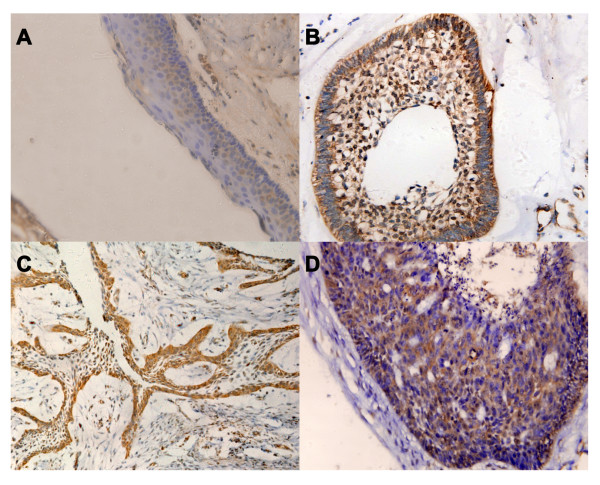
A representative immunohistochemical reactivity for MMP-2. (A) Keratocystic odontogenic tumor showing moderate reactivity in prickle cells (× 400); (B) Follicular ameloblastoma showing strong reactivity in peripheral columnar cells (× 400); (C) Plexiform ameloblastoma showing strong reactivity in peripheral columnar cells (× 200); (D) Ameloblastic carcinoma showing strong reactivity in tumor cells (× 400).